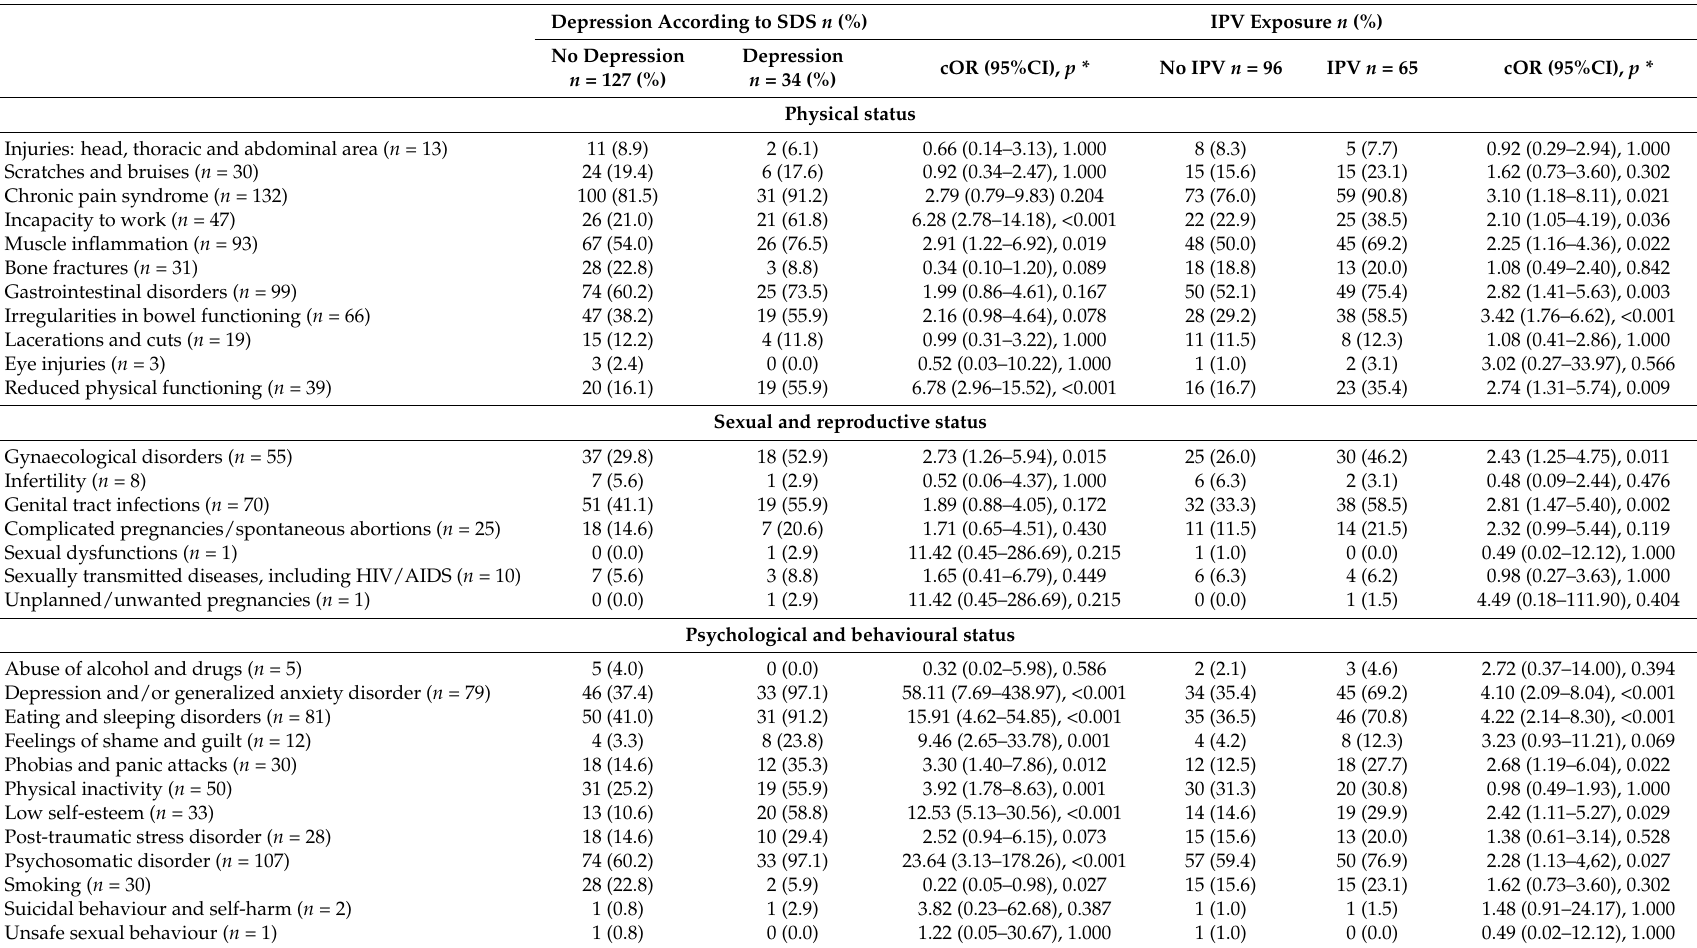
Table 4. Patients’ medical charts review summary taking into account self-rated depression and IPV exposure in